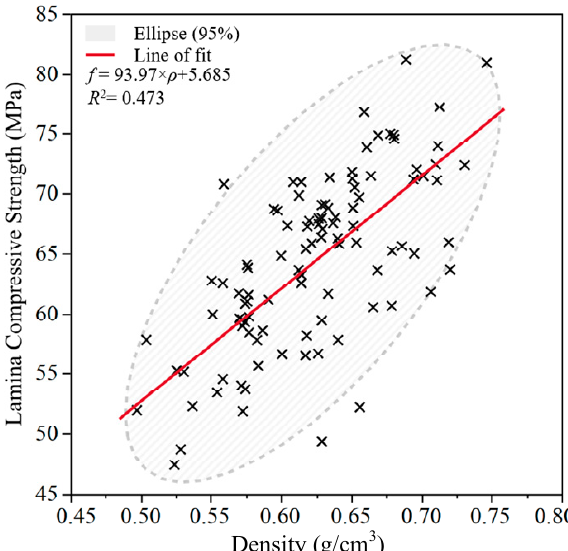
Figure 7. Relationship between compressive strength and density of the